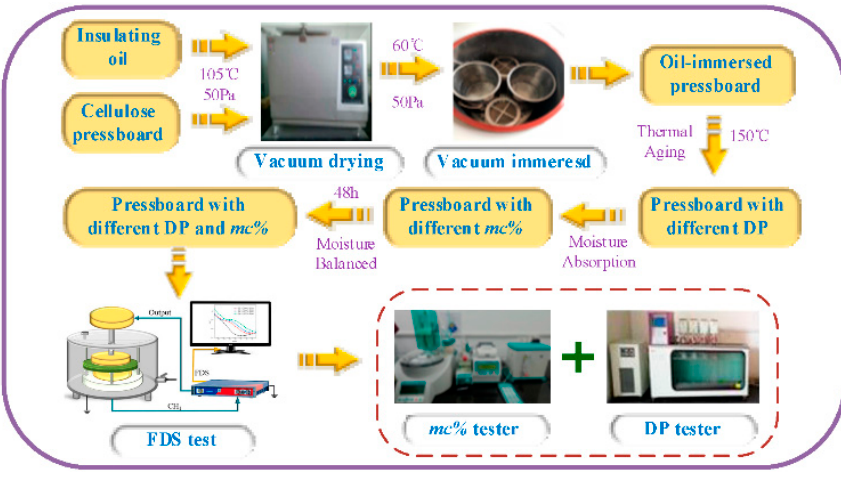
Figure 1. Schedule of sample preparation and insulting information testing. Table 2. Classification of moisture content in oil-immersed insulation.